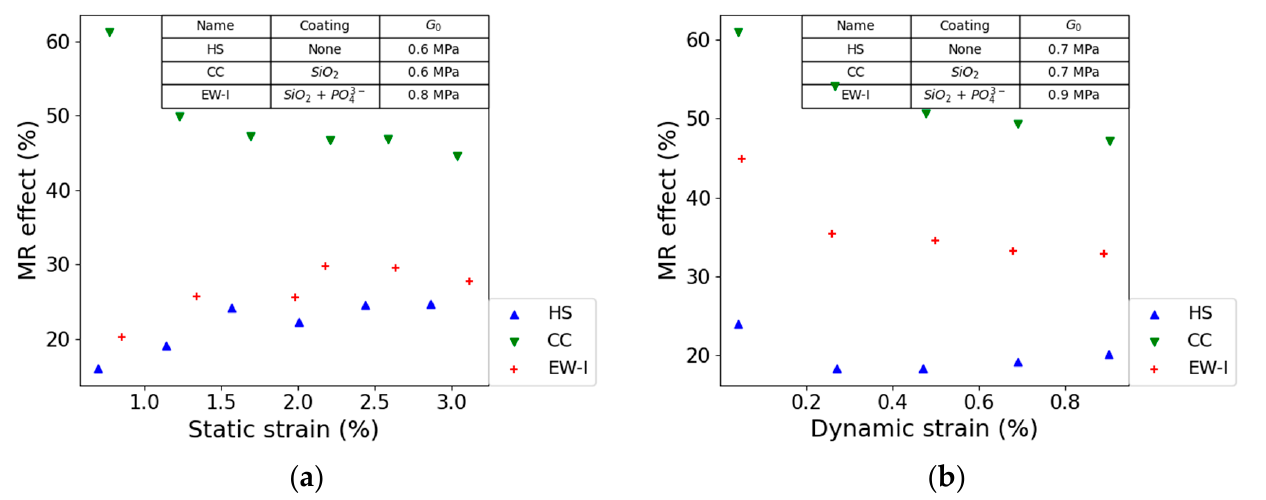
Figure 10. The effect of static ( a ) and dynamic ( b ) strain on MR effect. For this investigation, STL30HS, STL30CC, and STL30EW-I composites were used. All samples contain 30 vol.-% CIP in an STL matrix. A constant strain amplitude of 1%was used for the static tests. A constant frequency of 10 Hz and field strength of 0.54 T were used for both test condi- tions.